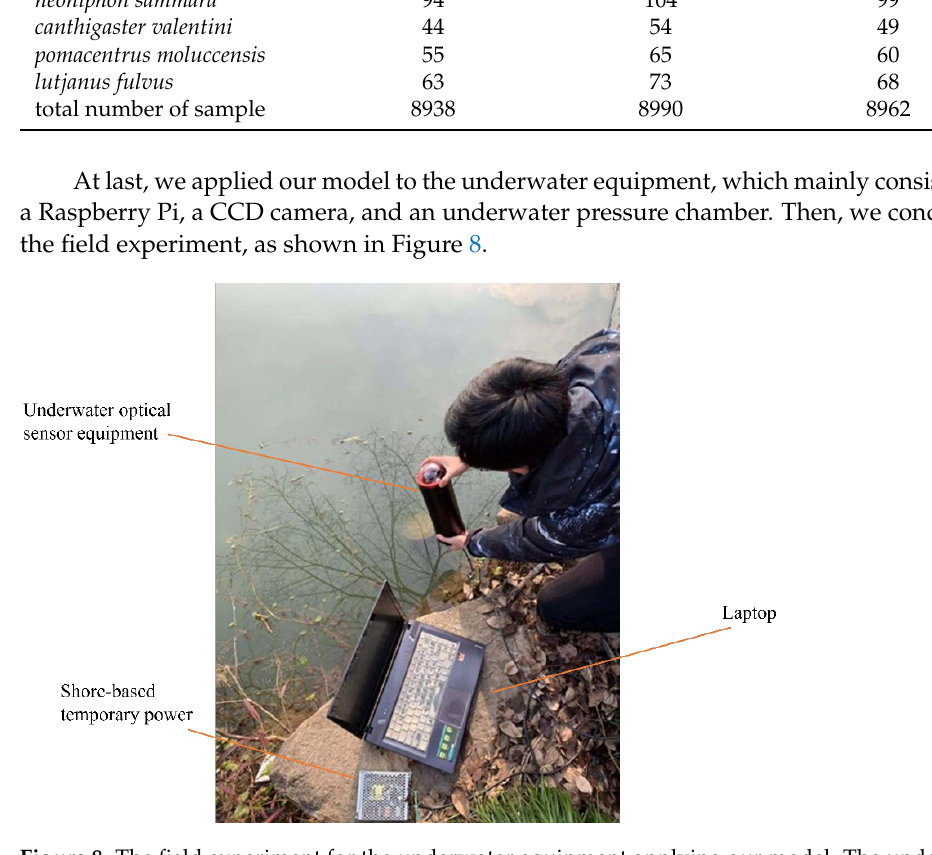
Figure 8. The field experiment for the underwater equipment applying our model. The underwater optical sensor equipment consists of a Sony IMX322 optical sensor, a raspberry pie with ARM Cor- tex-A53, and a high hydrostatic pressure